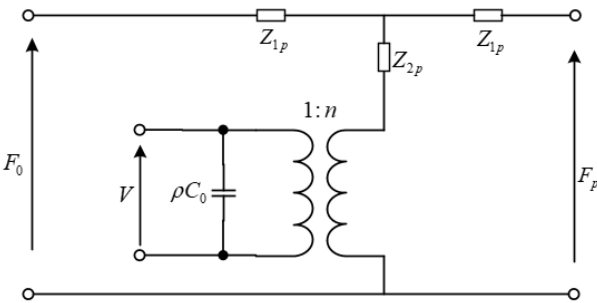
Figure 3. Electromechanical equivalent diagram of the laminated